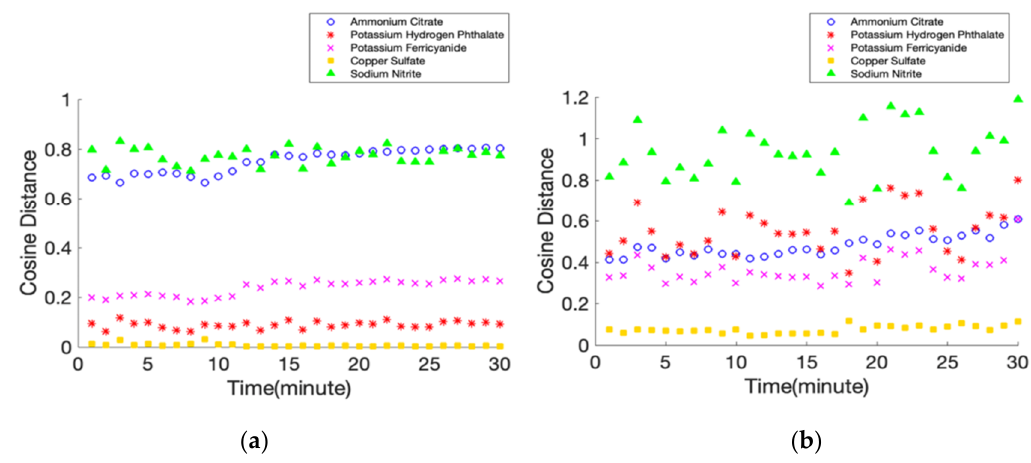
Figure 8. Classification results of 10 mg/L Copper Sulfate solution before and after the fusion of cross-correlation information. ( a ) Before the introduction of cross-correlation information; ( b ) after the introduction of cross-correlation information.